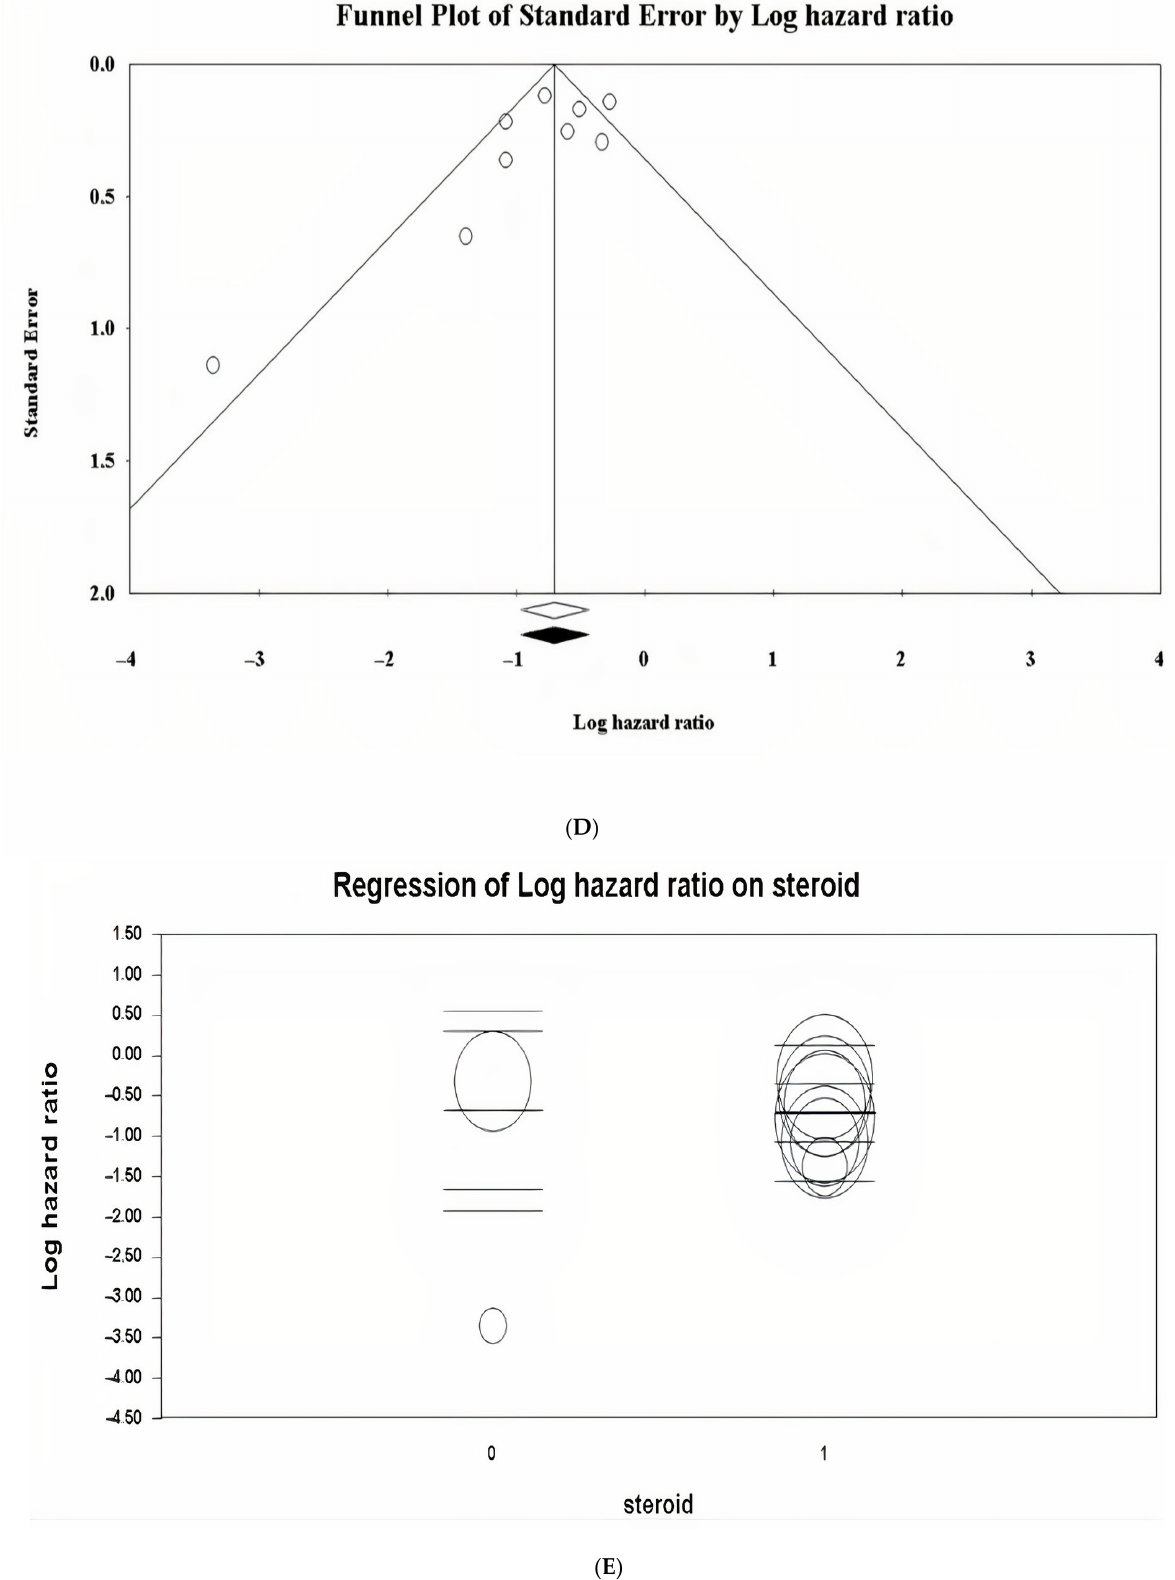
Figure 2. ( A ). Random-effects model forest plot of the impact of Tocilizumab on death rate in cases receiving tocilizumab plus standard care versus controls receiving standard care, according to studies reporting unadjusted estimates (crude events). The forest plot shows a high amount of heterogeneity among studies and a borderline protective effect of tocili- zumab. ( B ) Funnel plot of the random-effects model of the impact of Tocilizumab on death rate in cases receiving tocili- zumab plus standard care versus controls receiving standard care, according to studies reporting unadjusted estimates (crude events). It shows no evidence of publication bias. ( C ) Random-effects model forest plot of the impact of Tocilizumab on death rate in cases receiving tocilizumab plus standard care versus controls receiving standard care, according to stud- ies reporting adjusted estimates. The forest plot shows a high amount of heterogeneity among studies and a protective effect of tocilizumab. ( D ) Funnel plot of the random-effects model of the impact of Tocilizumab on death rate in cases receiving tocilizumab plus standard care versus controls receiving standard care, according to studies reporting adjusted estimates. It shows no evidence of publication bias. ( E ) Meta-regression showing no statistically significant difference between the use of tocilizumab plus standard care i.e., without steroid (0) and the concomitant use of steroids (1) in terms of mortality rate. The number of studies was substantially reduced on pooling together the studies re- porting adjusted effect sizes ( n = 8 studies, k = 9), applying the random-effects model due to the significant amount of heterogeneity among studies (Q = 21.98, DF = 8, I 2 = 63. 61%), tocilizumab therapy showed an overall protective effect with an HR of 0.50 ([95%CI 0.38– 0.64], p < 0.001) (Figure 2C). No effect of publication status (pre-print versus published in peer-reviewed journal; p = 0.9346) could be detected, as well as no publication bias (Figure 2D). 3.6.2. Impact of Concomitant Corticosteroid Use on Survival To study the impact of concomitant use of steroids, an exploratory meta-regression was conducted. Results of the meta-regression ( p = 0.9450) indicated that tocilizumab ad- ministration was effective in both treatment cohorts, that is to say in those utilizing ster- oids and in those to whom corticosteroids were not administered. Tocilizumab with con- comitant steroid use versus standard care, that may have also included steroid was pro- tective with an OR 0.49 ([95%CI 0.36–0.65], p < 0.05), but it was not possible to accurately